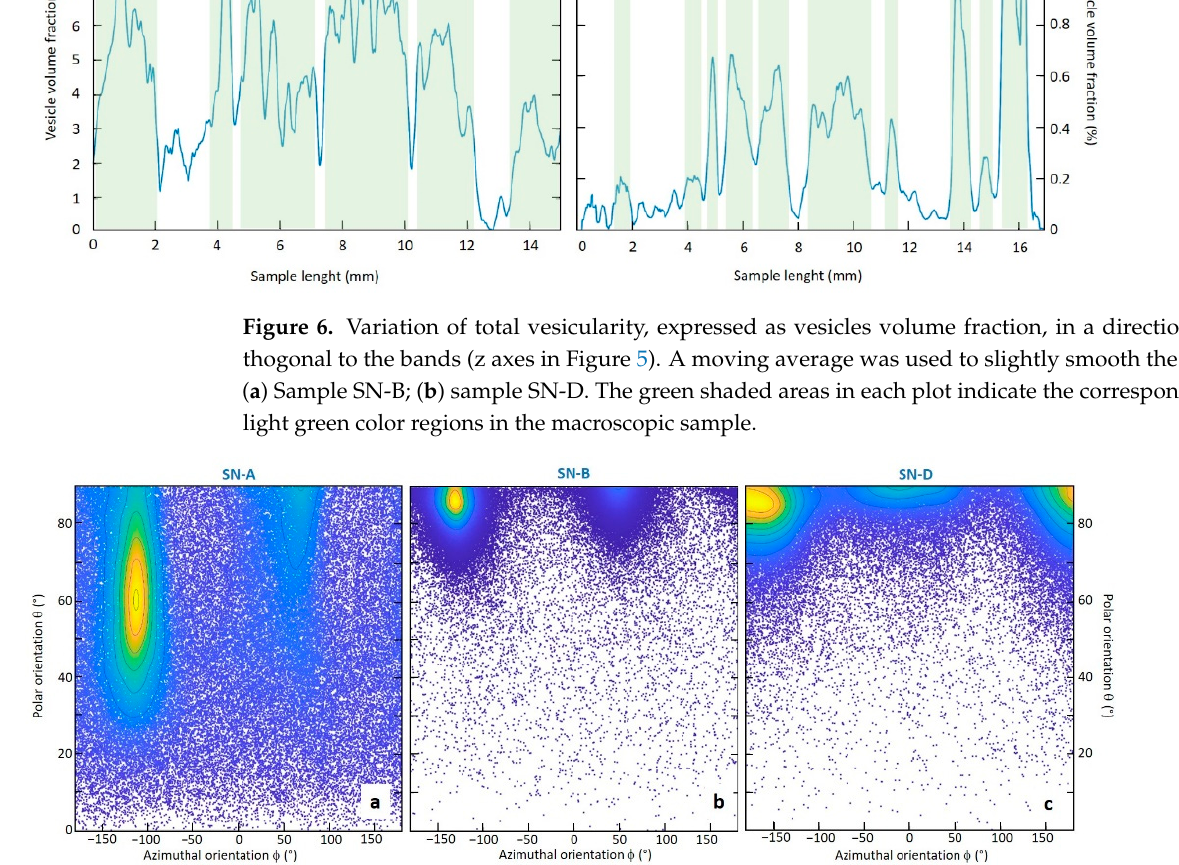
Figure 7. Scatterplot of the azimuthal and polar orientation of the major axes of the vesicles. The reference system is shown in Figure 5. A density function has been overlapped to the scatter plots to highlight the preferential orientation(s). Yellow indicates the highest concentration of points, blue the lowest. ( a ) Sample SN-A; ( b ) sample SN-B; ( c ) sample SN-D.